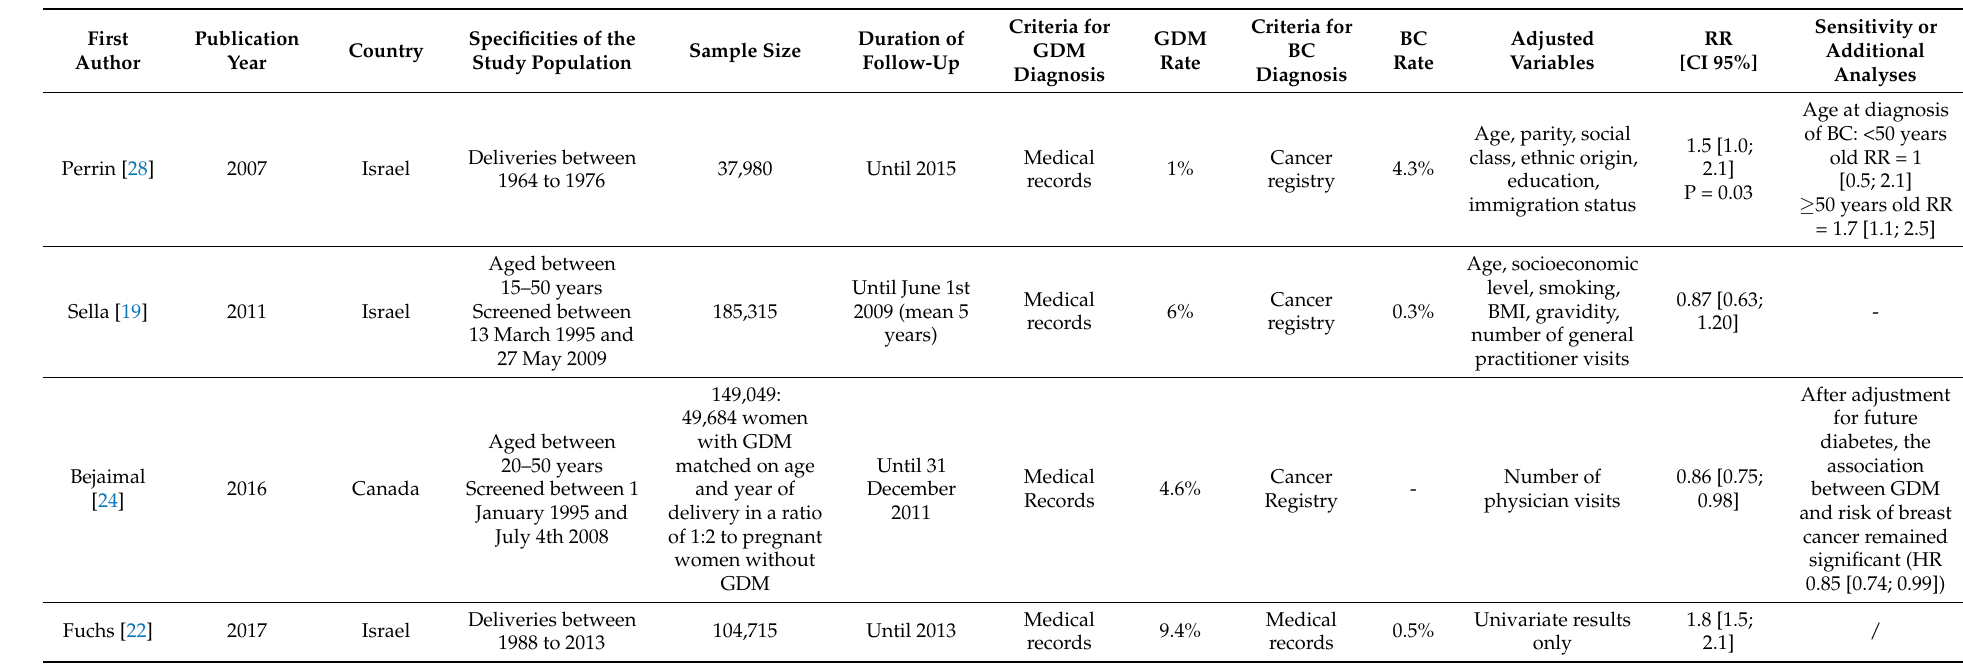
Table 1. Characteristics of the cohort